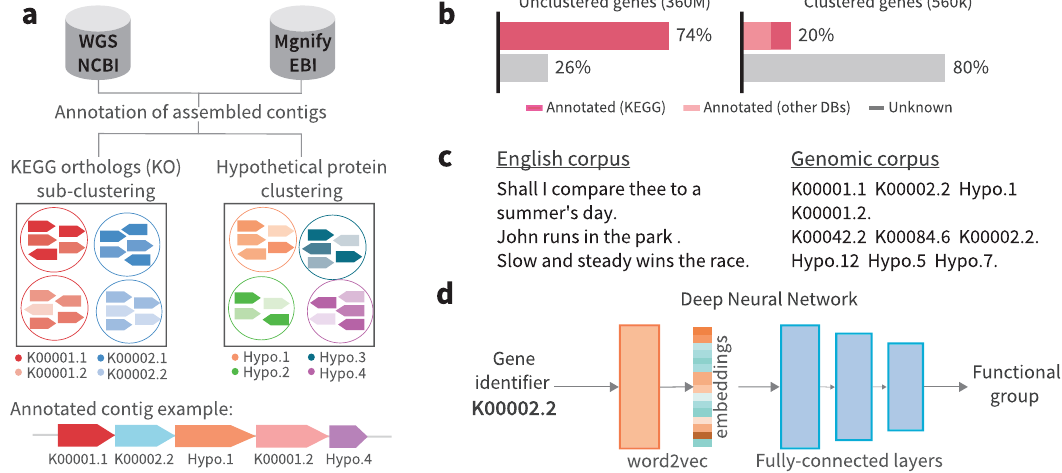
Fig. 1 | Model work fl ow. a Data processing and annotation. Assembled contigs from public databases were downloaded and underwent gene calling and annota- tion. Both annotated and unannotated genes were clustered into gene families. b Distributionofannotatedandhypotheticalgenesinthecorpus.Theleftbarchart representsall~360milliongenesusedinthecorpus.Therightbarchartrepresents ~560,000 unique gene families (i.e., the corpus “ vocabulary ” ). c A comparison